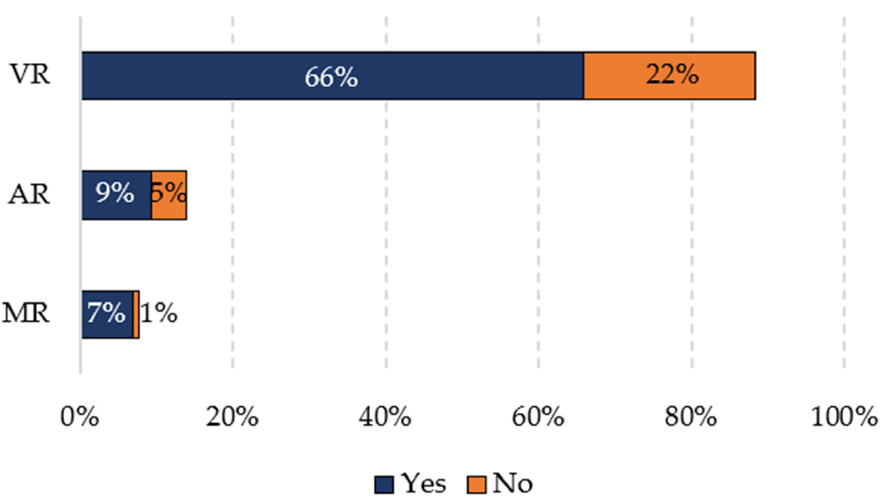
Figure 5. Number of studies that use or do not use some method to measure the effectiveness of XR experiences according to the technologies